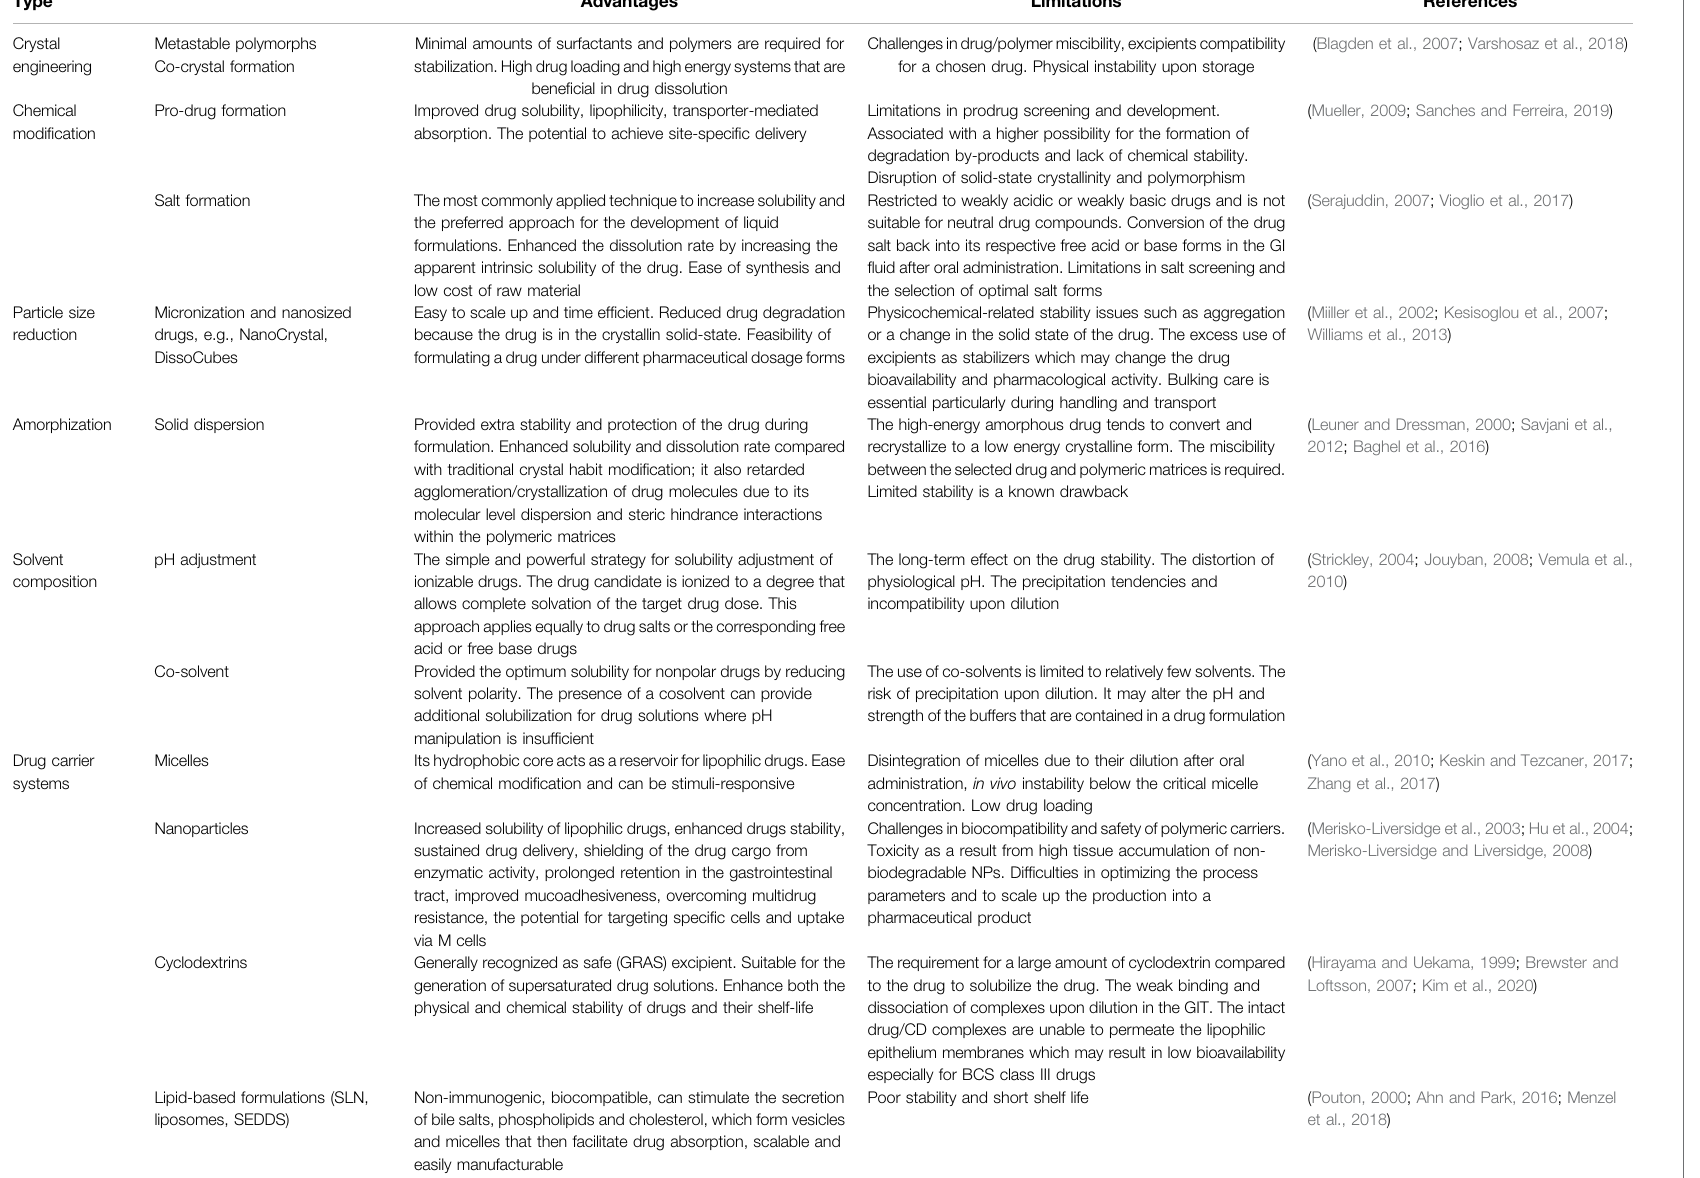
TABLE 4 | Different strategies to enhance the aqueous solubility of